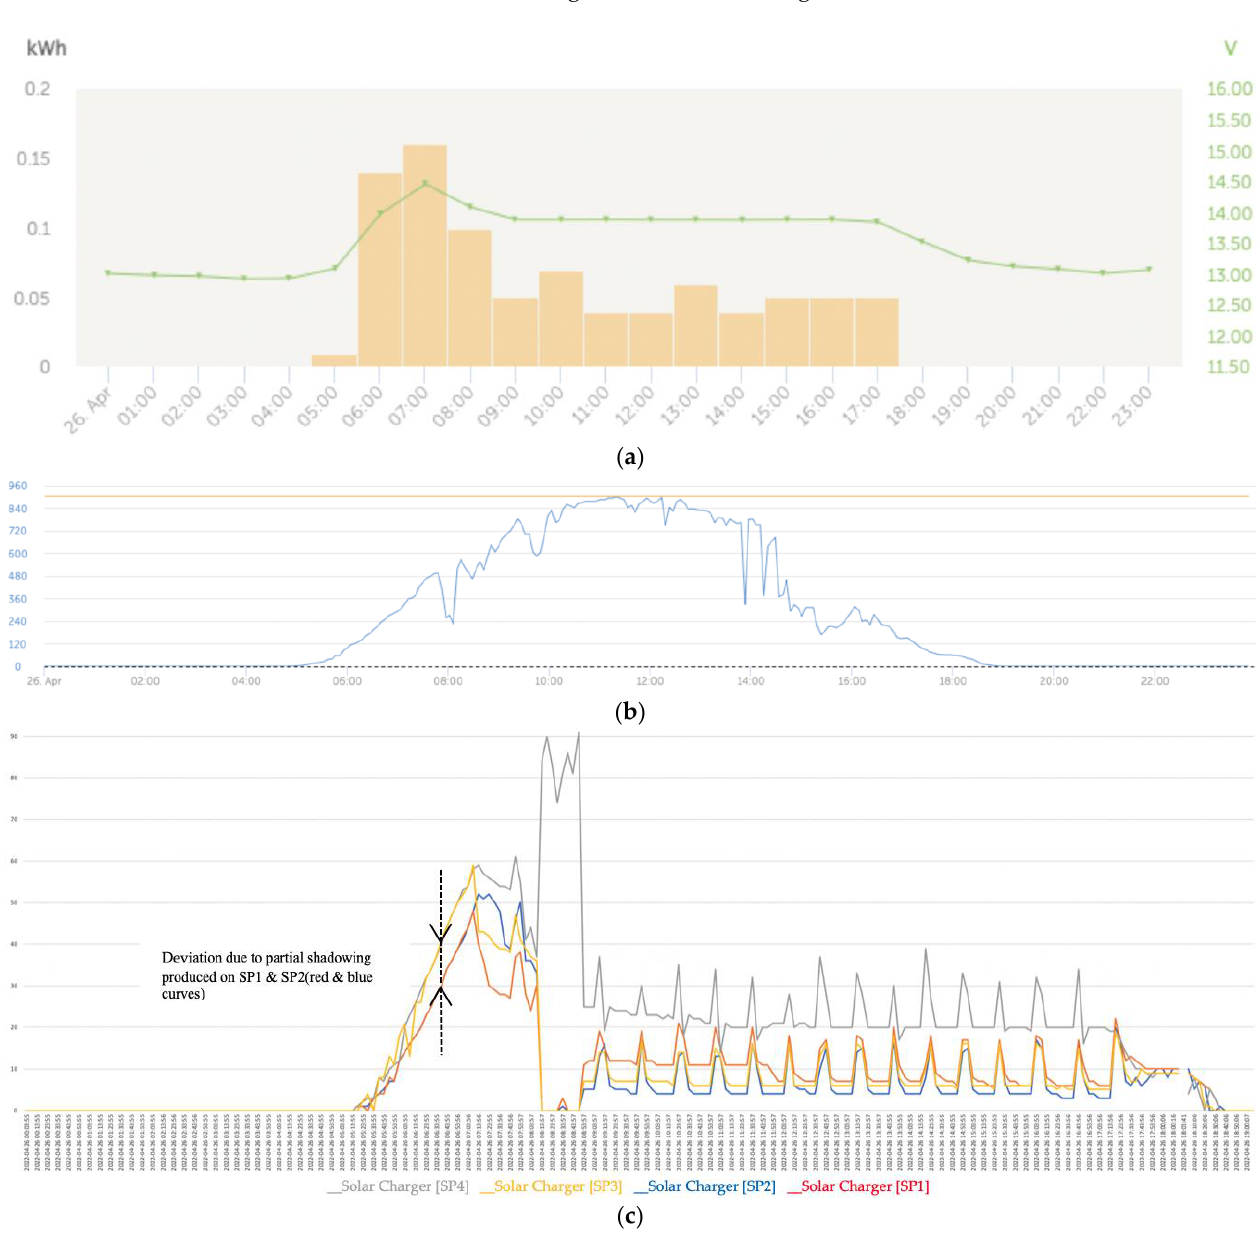
Figure 17. ( a ) Daily charge phases: initial, absorption, and flotation (26 April). ( b ) Solar irradiance in W/m 2 (26 April). ( c ) Deviation trend comparative PV power data series analysis due to partial shading in watts (26 April).